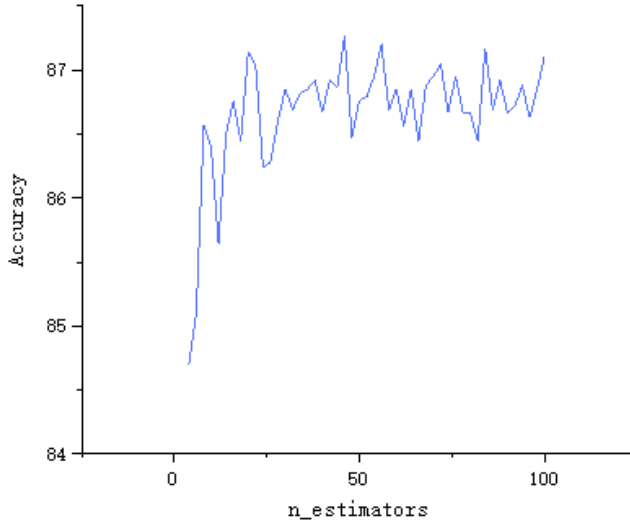
Figure 10. Influence of n_estimators parameter on the accuracy of RF algorithm.